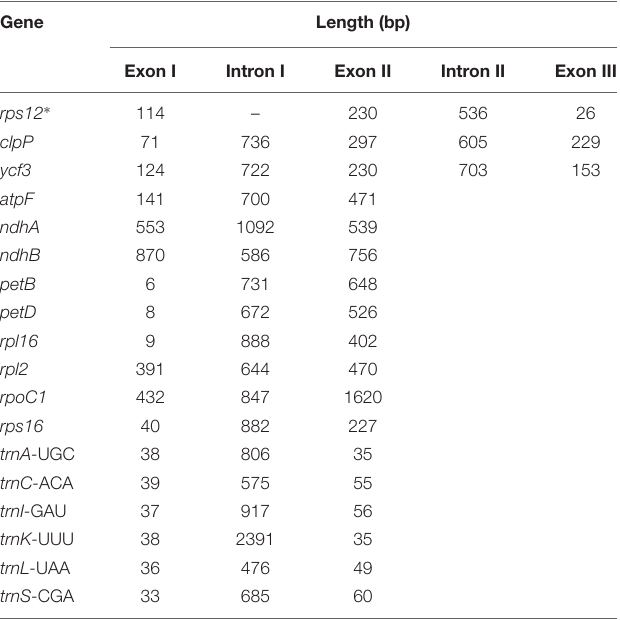
TABLE 3 | Length of intron and exon splitting genes in the S. cusia cp